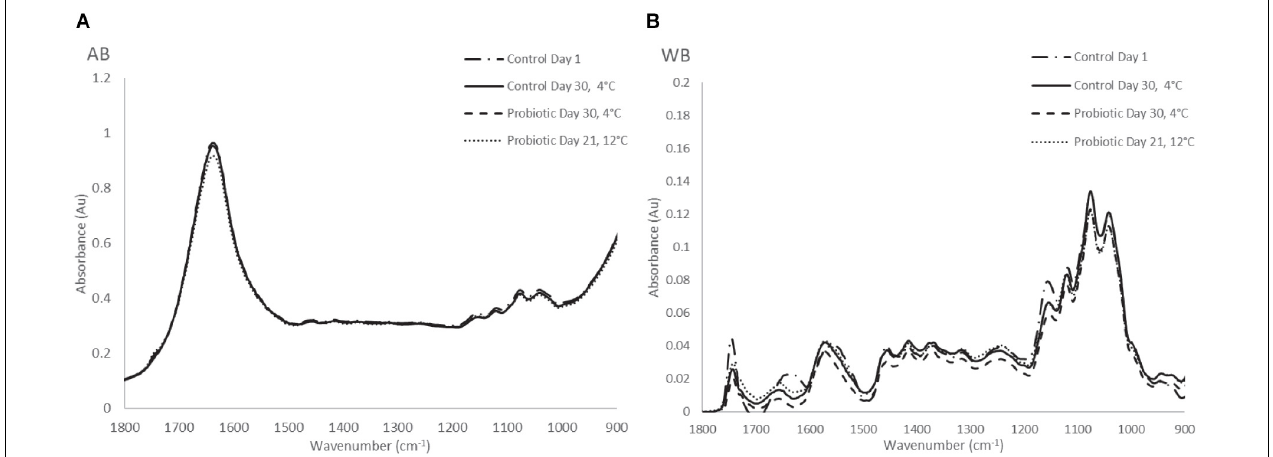
FIGURE 5 | (A) Raw FTIR spectra of air background (AB), and (B) water background (WB) collected from yogurt samples during storage at 4 and 12 ◦